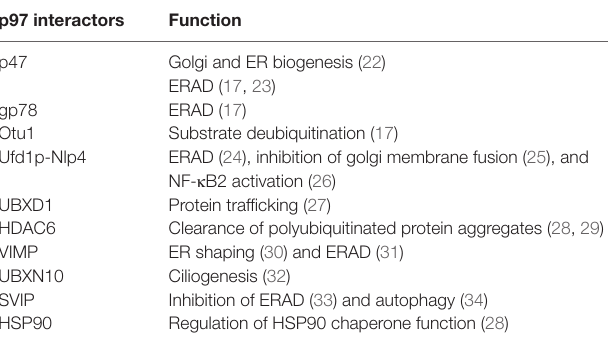
TABLe 1 | A partial list p97 interacting proteins and their associated